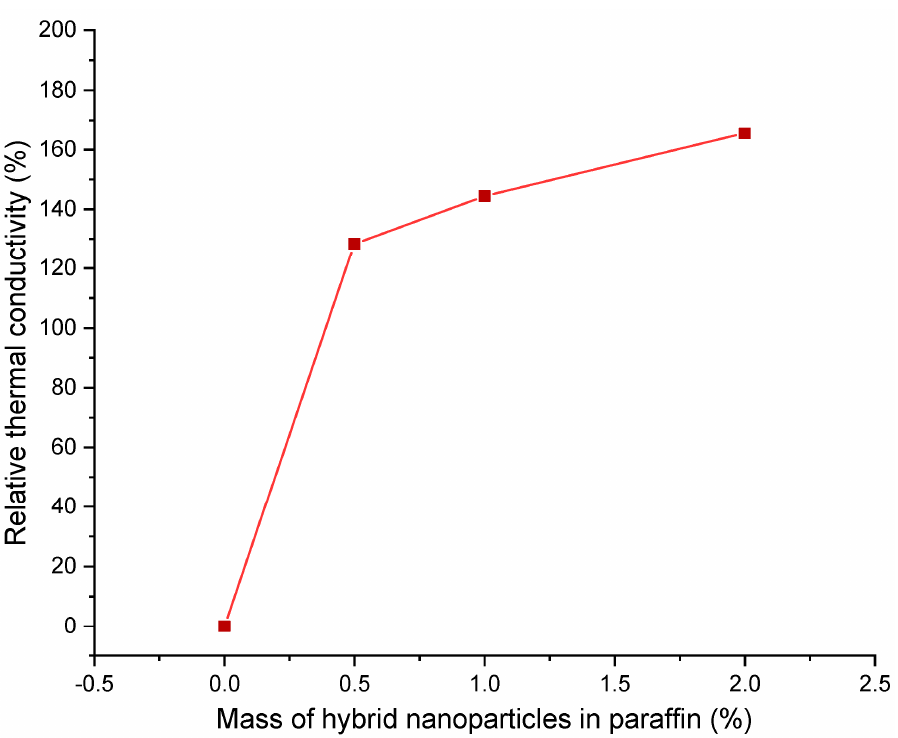
Figure 8. The relative enhancement in thermal conductivity with the addition of NPs